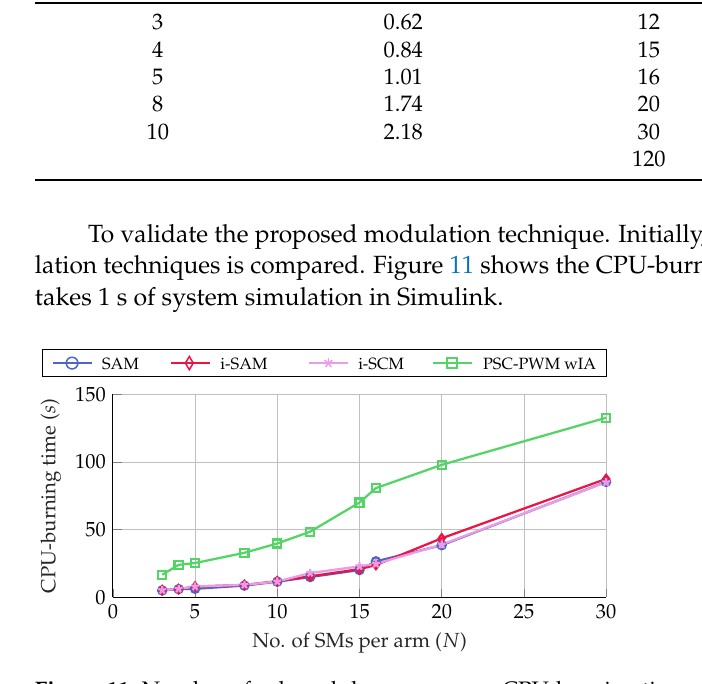
Figure 11. Number of submodules per arm vs. CPU-burning